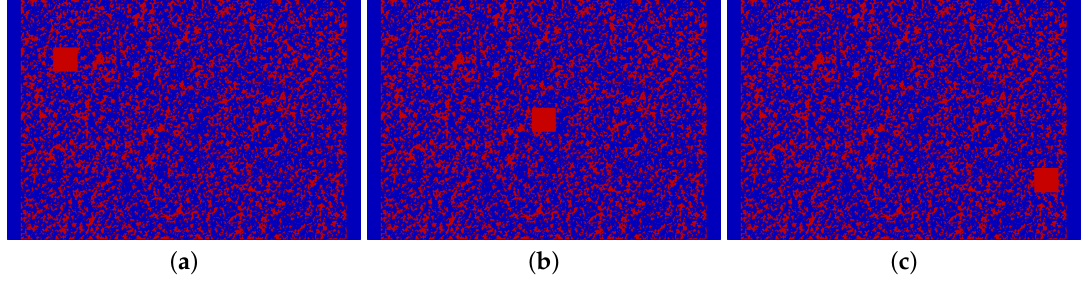
Figure 6. Reconstructed computational domains based on the experiments of [51]. The single catalyst particle is represented by the red square, while the fluid domain is represented in blue. Pulsed flow goes from left to right; ( a ) Case A; ( b ) Case B; ( c ) Case